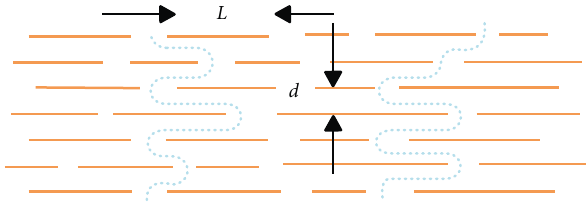
Figure 9: Graphene oxide membrane with nanopores